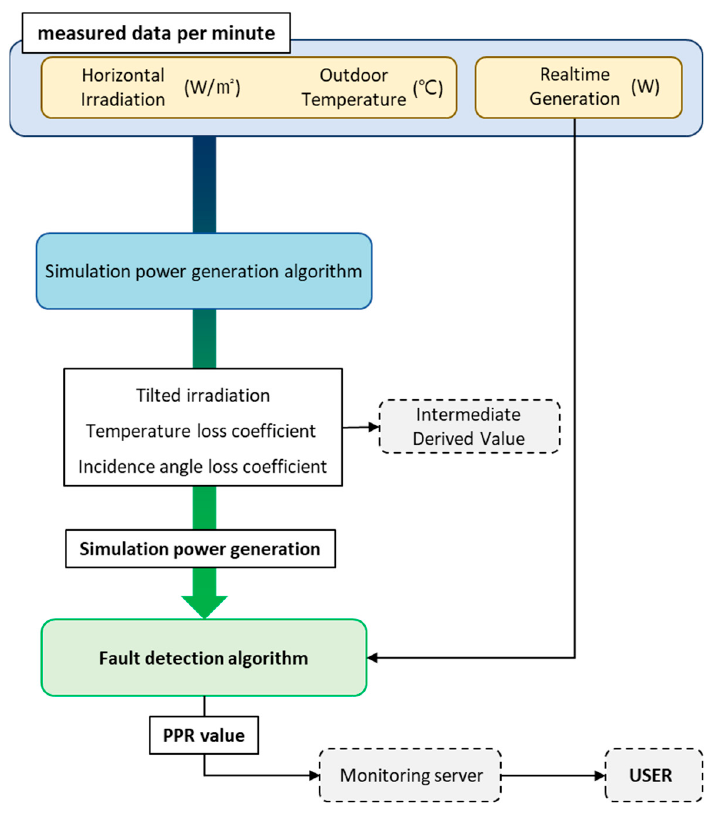
Figure 1. Process flow diagram of monitoring system.